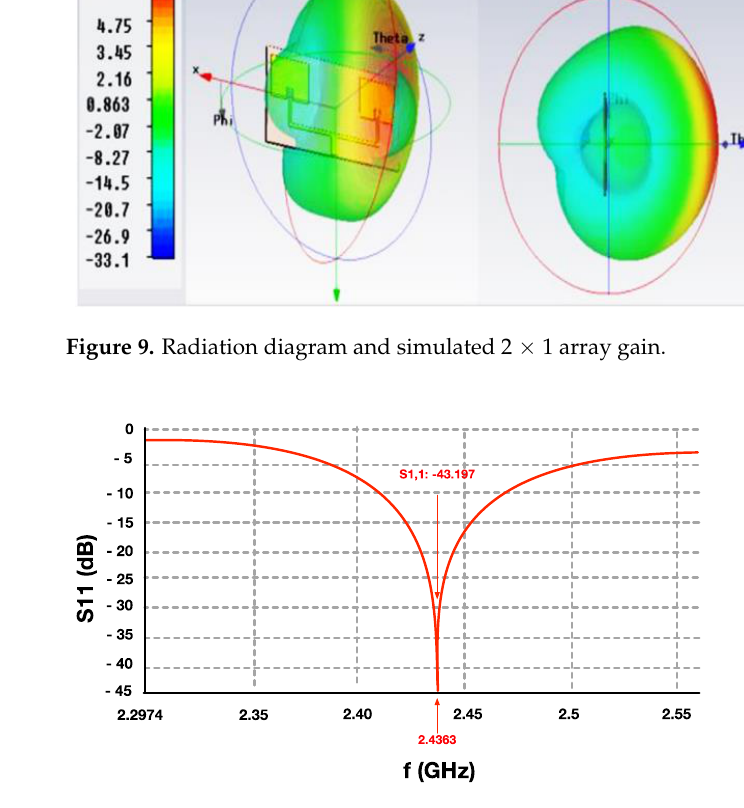
Figure 10. Parameters S 11 simulated 2 × 1 array.